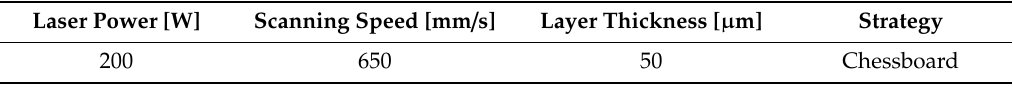
Table 2. Settings of process parameters for production SLM